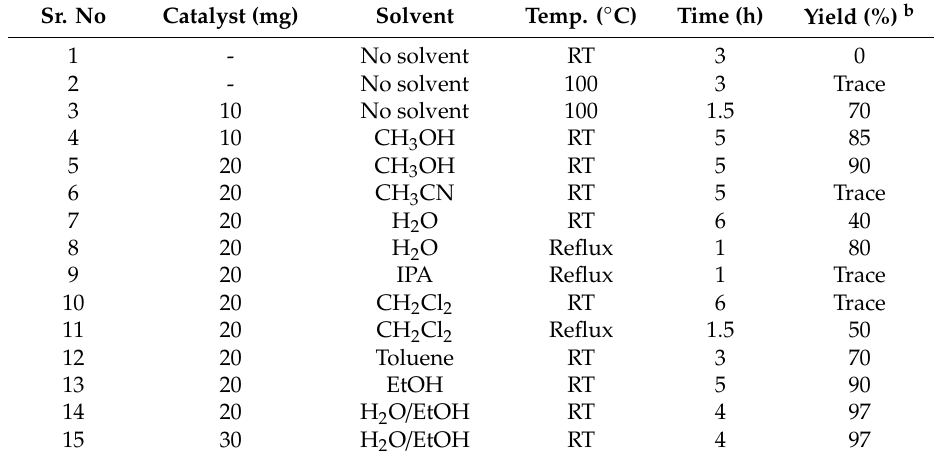
Table 1. The optimization of reaction parameters for the synthesis of chromene derivatives a . Sr. No